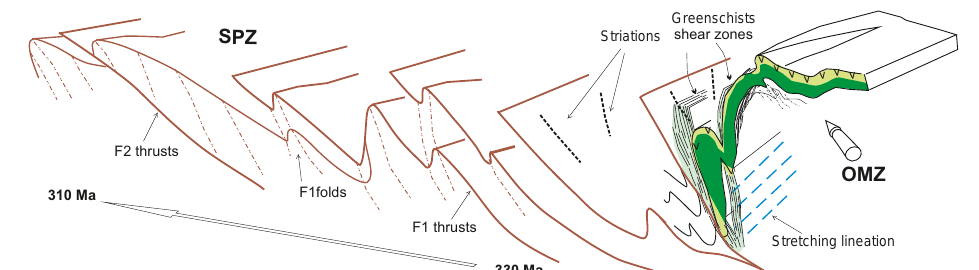
Figure 6. (a–c) Evolutionary model of the BA unit during the Carboniferous transpression, from northward obduction to southward propa- gation of the deformation. Modified from Pérez-Cáceres et al. (2015).